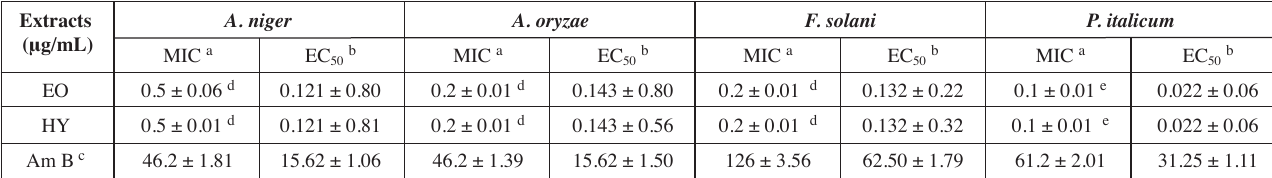
Tab. 2: Antifungal activity of essential oil (EO) and hydrosol extract (HY) of T. capitatus against A. niger, A. oryzae, P. italicum and F. solani .